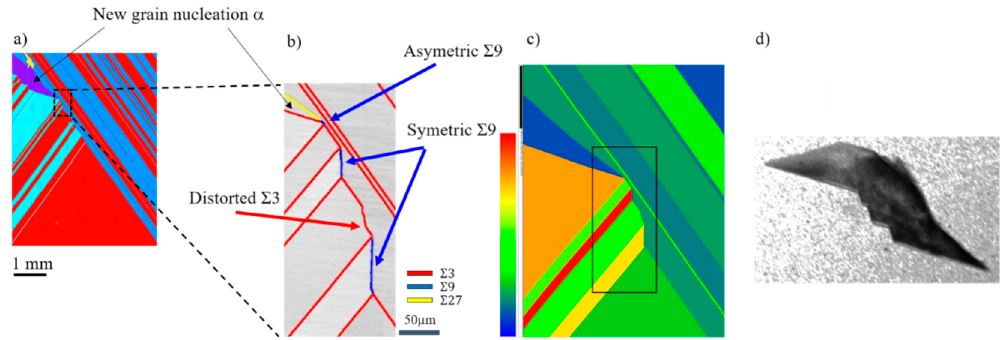
Figure 9. ( a ) Inverse Pole Figure (IPF) map along the growth direction (same experiment as in Figure 2, Figure 5a, Figure 6a, and Figure 8a,b). ( b ) High resolution CSL map of the region where competition between twins take place. ( c ) Grain orientation spread (GOS) map of the region of the new nucleated grain ( α ). ( d ) Topograph of the grain ( α ).